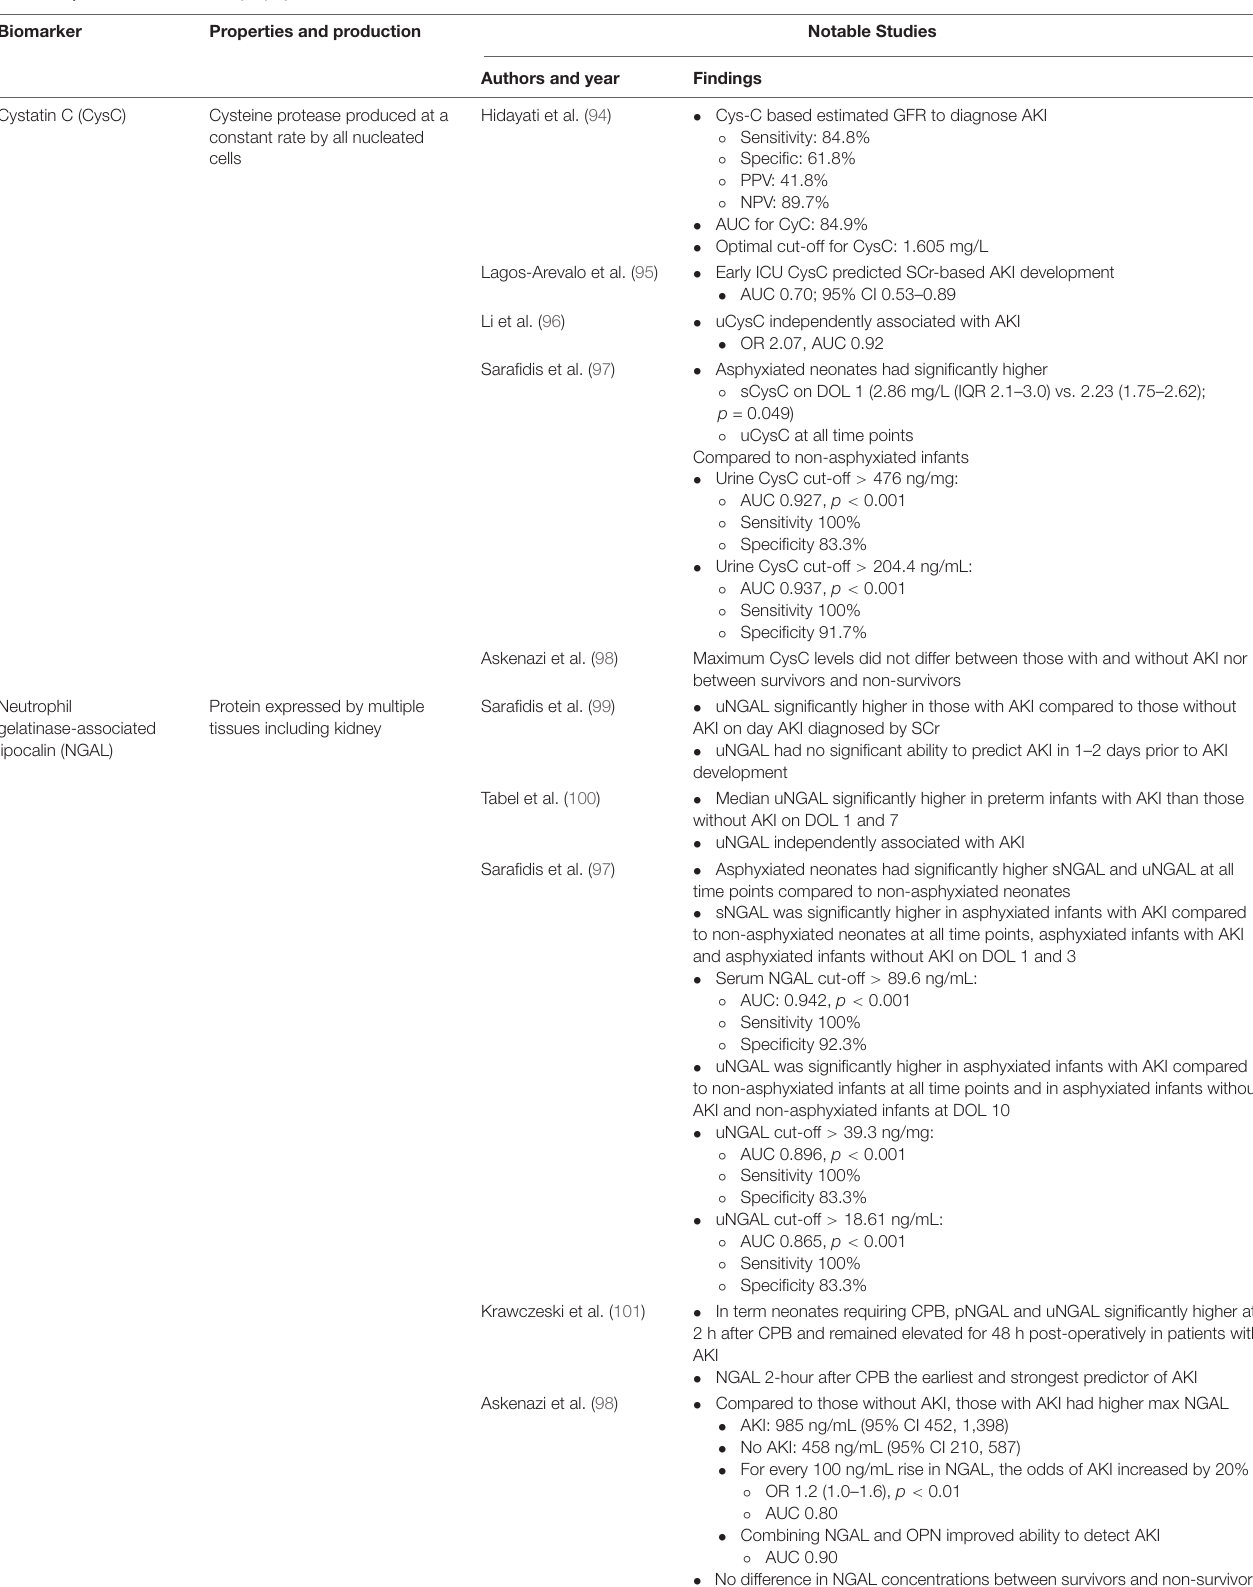
TABLE 4 | Neonatal acute kidney injury